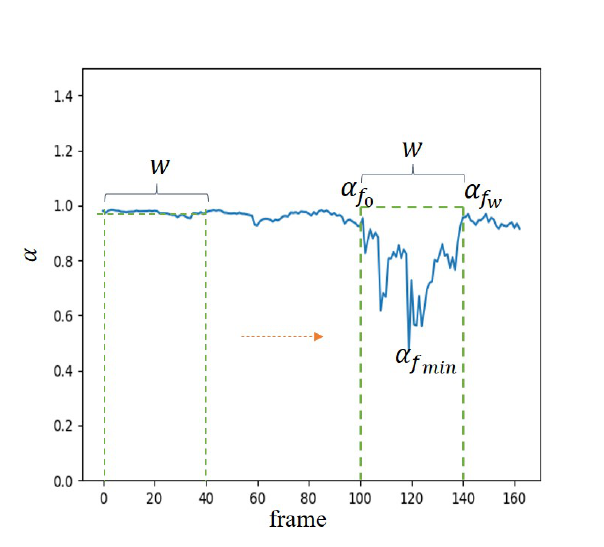
Figure 5. The sliding window